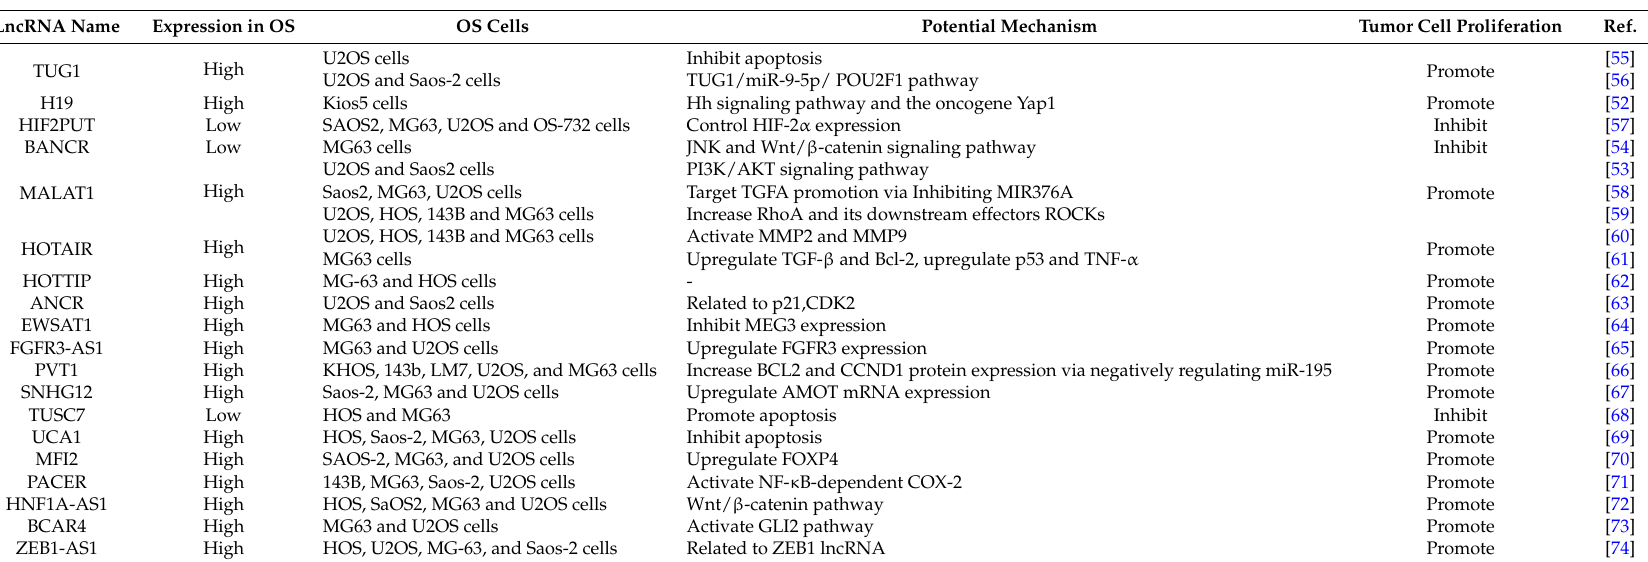
Table 1. Long non-coding RNAs associated with cell proliferation of